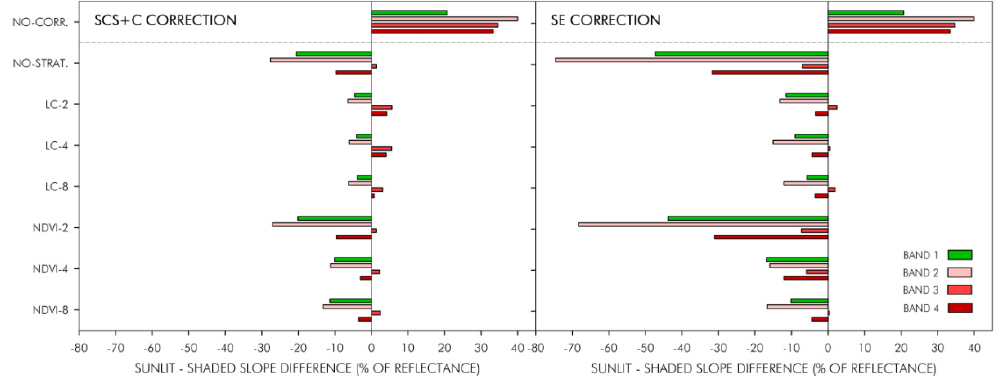
Figure 11. Reflectance difference between sunlit and shaded slopes for conifer forests.